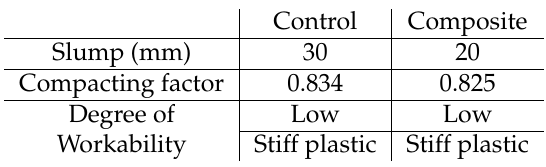
Table 4. Workability of specimens